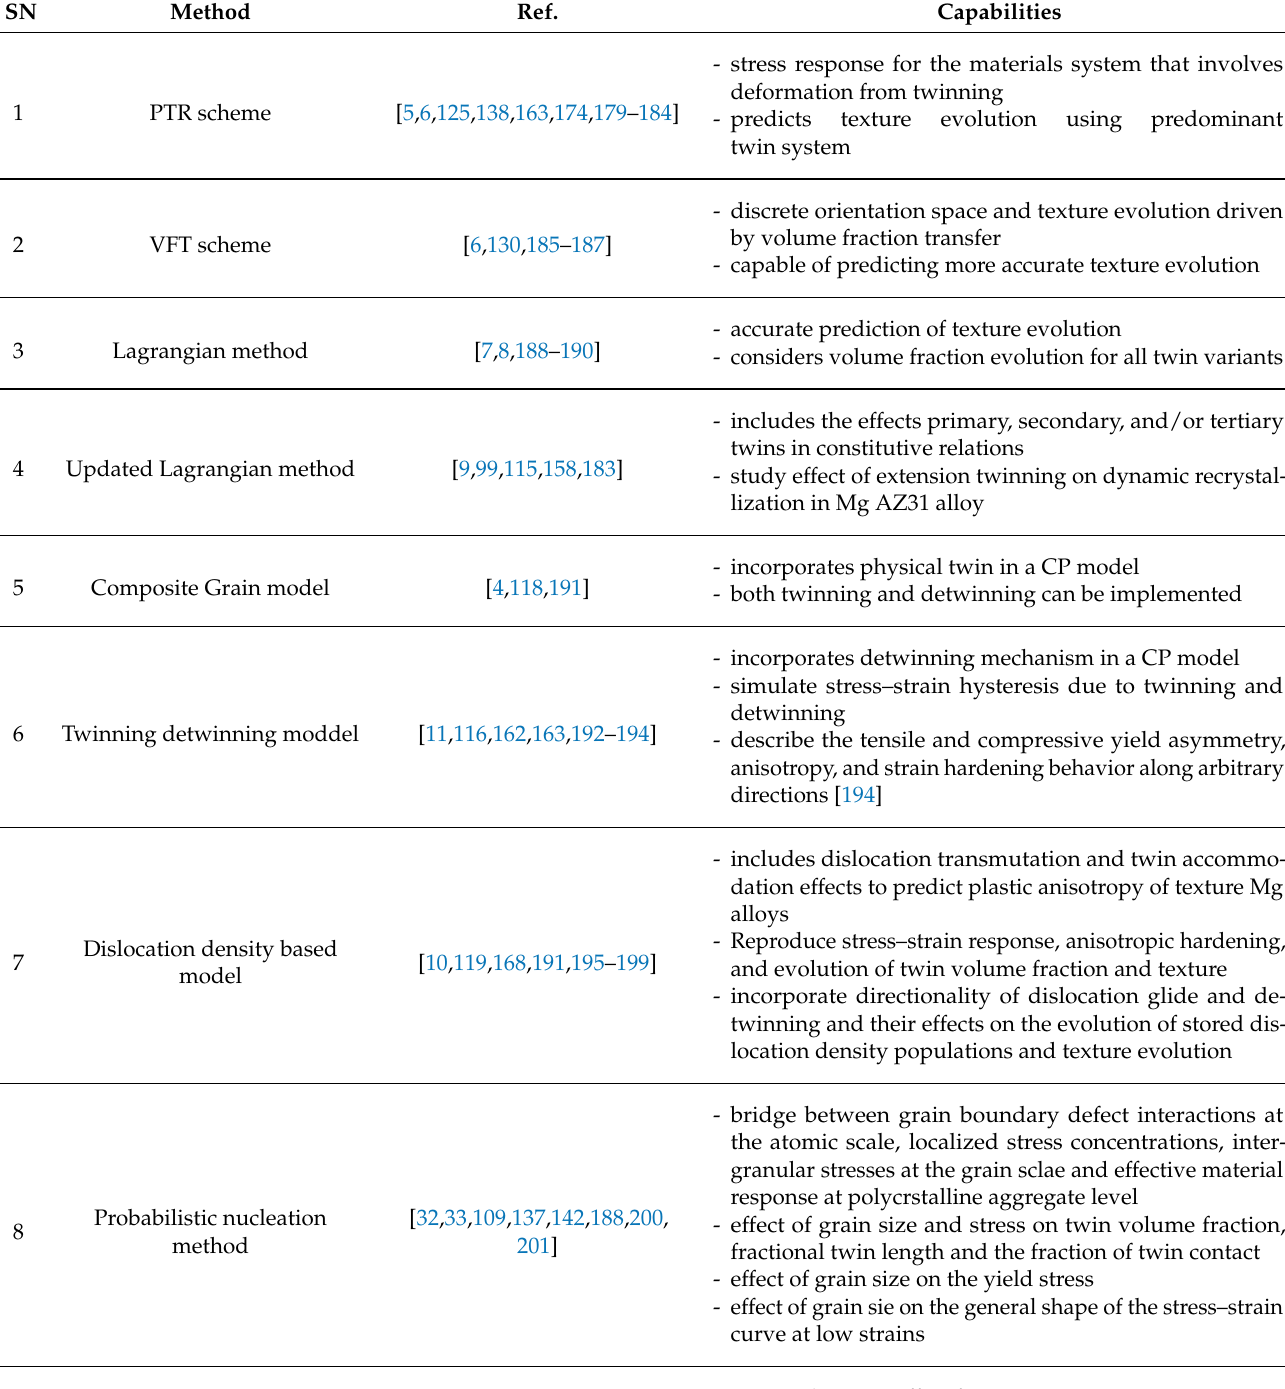
Table 1. A summary of twinning criteria used in crystal plasticity